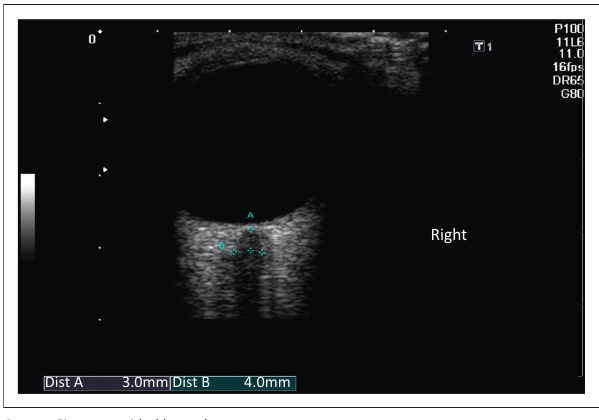
FIGURE 1: Ultrasound image of normal optic nerve sheath diameter.